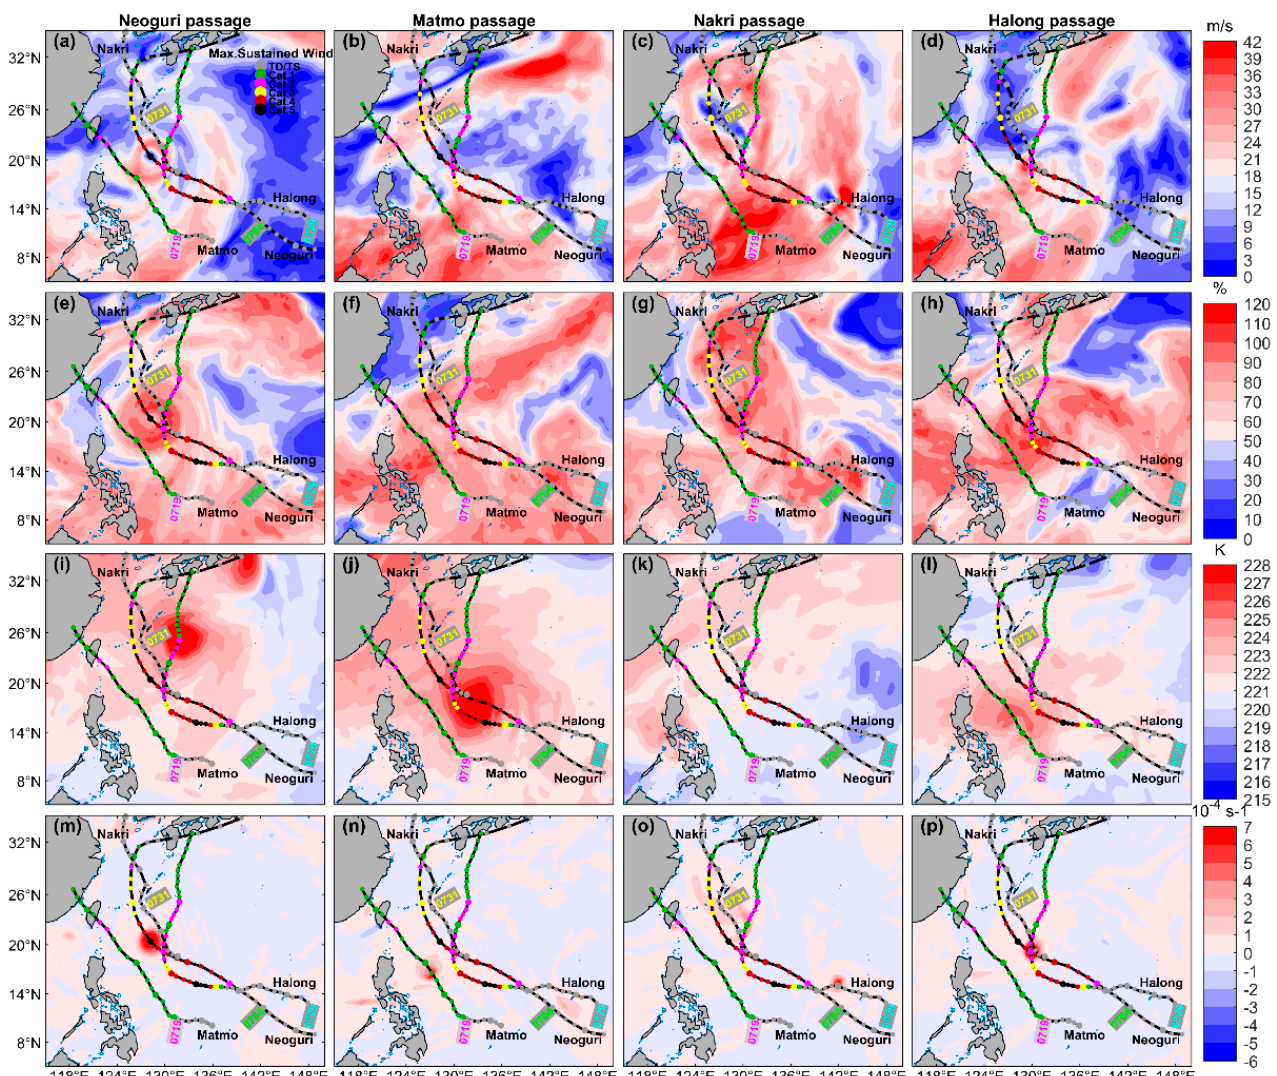
Figure 10. The evolutions of ( a – d ) vertical wind shear (200–850 hpa), ( e – h ) relative humidity at 600 hPa, ( i – l ) temperature at 200 hPa and ( m – p ) relative vorticity at 850 hPa during four sequential TCs. The colored lines represent the TC tracks.